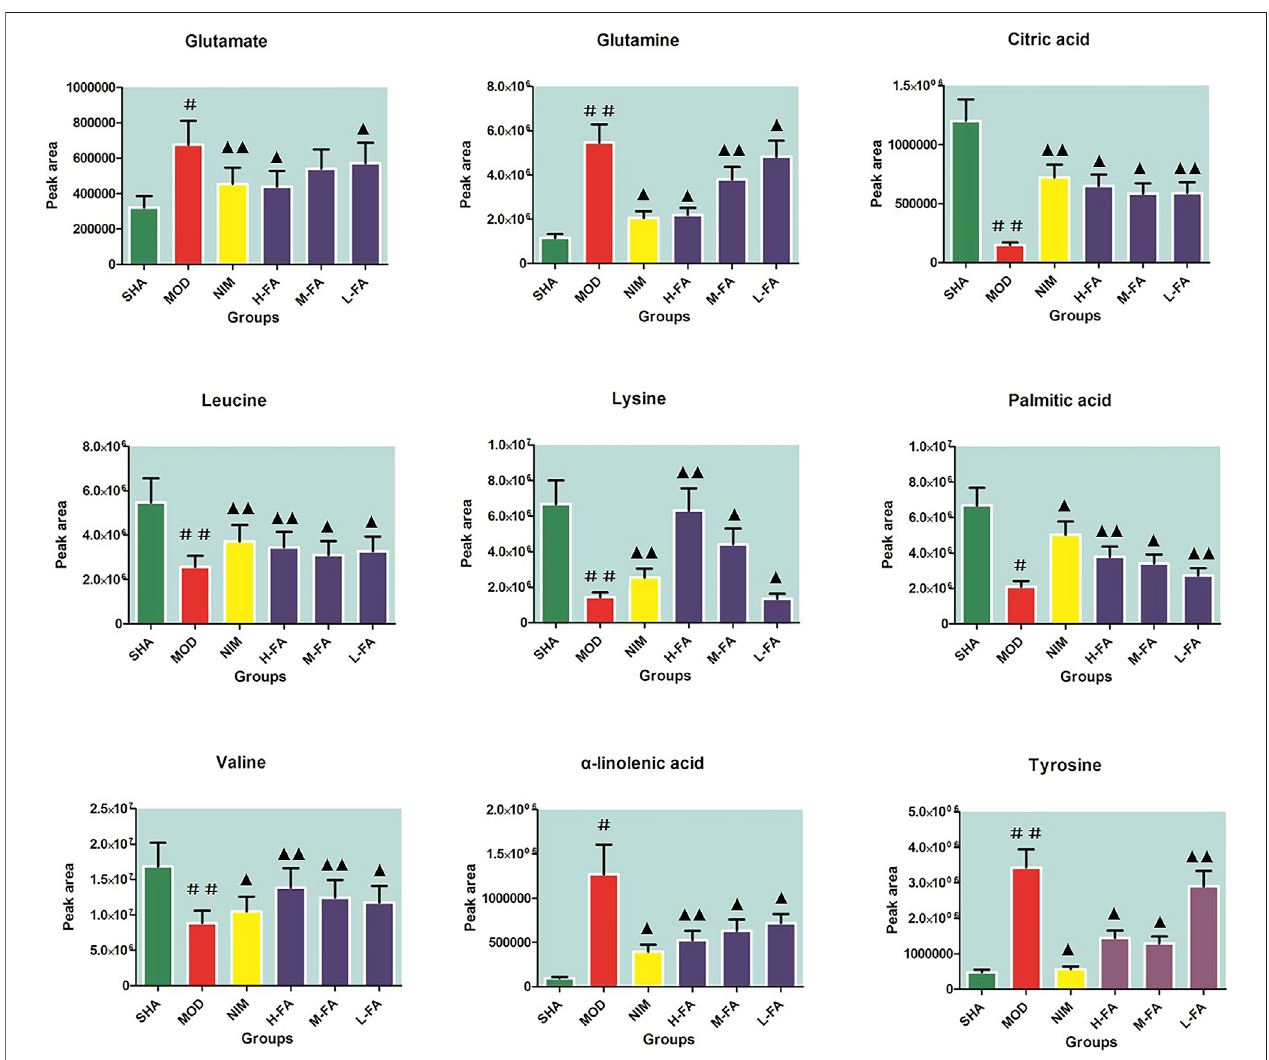
FIGURE 4 | The relative signal intensity calculation of common peaks in the SHA, MOD, NIM, L-FA, M-FA and H-FA groups as a semi-quantitative comparison objector ( n = 8 in every group). Data with statistical signi fi cance are represented as “ # ” or “ ▲ ” with a p -value less than 0.05. Data with statistical signi fi cance are represented as “ ## ” or “ ▲▲ ” with a p -value less than